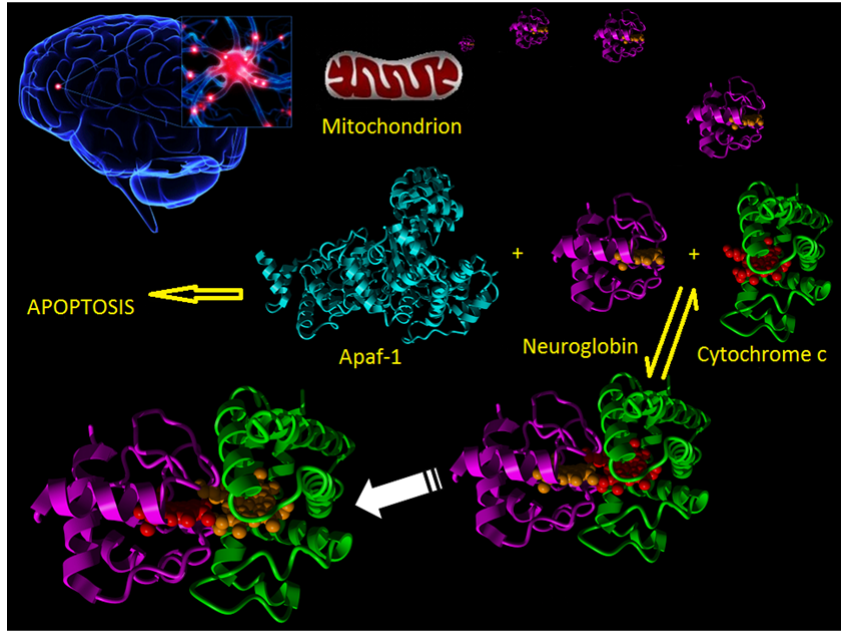
Figure 2. Cartoon showing the molecular events following a stroke. Neuron damage (top left) leads to mitochondrial release of cytochrome c (magenta) into the cytosol. In the cytosol cytochrome c can bind to either Apaf-1 (cyan) or neuroglobin (green). Binding to Apaf-1 leads to apoptosome formation and apoptotic cell death. Binding of cytochrome c to neuroglobin and subsequent reduction prevents cell death.